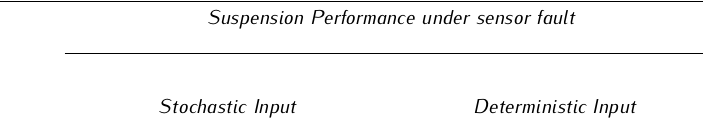
Table 3. Suspension performance under various sensor fault